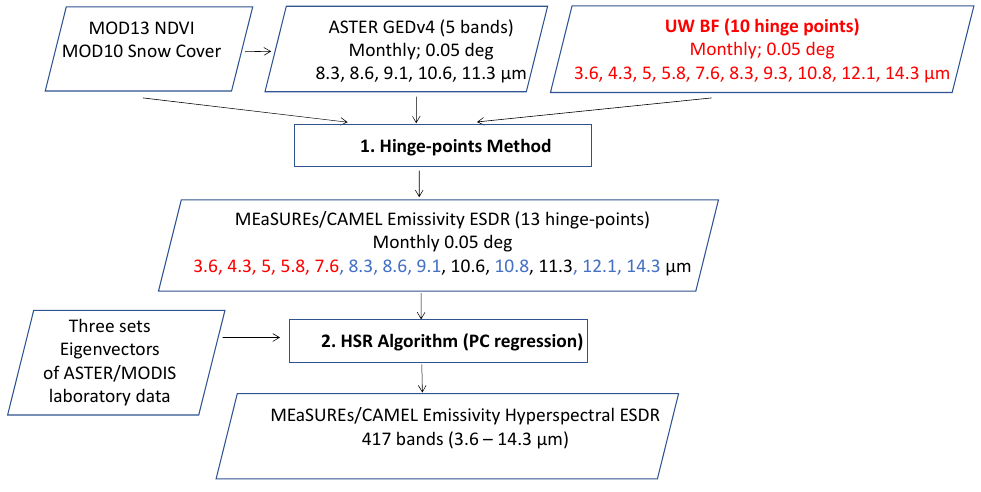
Figure 6. Making Earth System Data Records for Use in Research Environments (MEaSUREs) CAMEL Emissivity Earth System Data Record (ESDR) flowchart.